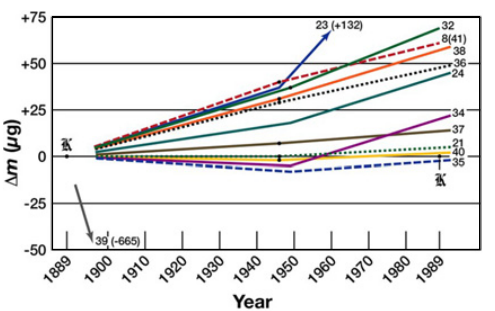
Figure 4. Kilogram definition and mass drift over time of national prototypes K21-K40, plus two of the IPK’s sister copies: K32 and K8(41) (Wikipedia).